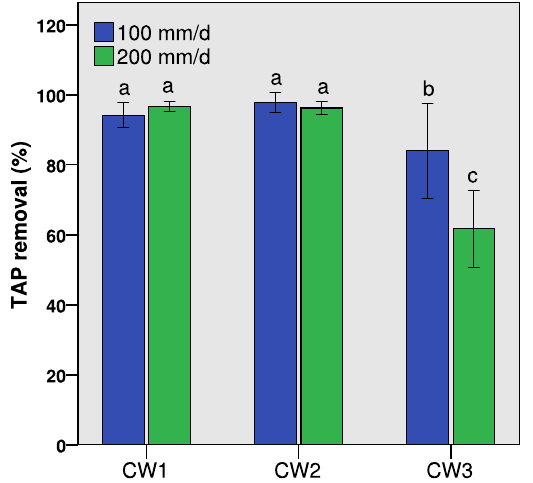
Figure 1. TAP removal efficiencies in the horizontal flow constructed wetlands (HSCWs) fed with mean influent TAP concentrations of 0.12 ± 0.04 mg L − 1 (CW1), 0.79 ± 0.29 mg L − 1 (CW2) and 3.96 ± 1.17 mg L − 1 (CW3) at HLRs of 100 mm d − 1 and 200 mm d − 1 . Different letters indicate significant differences among the columns (P <